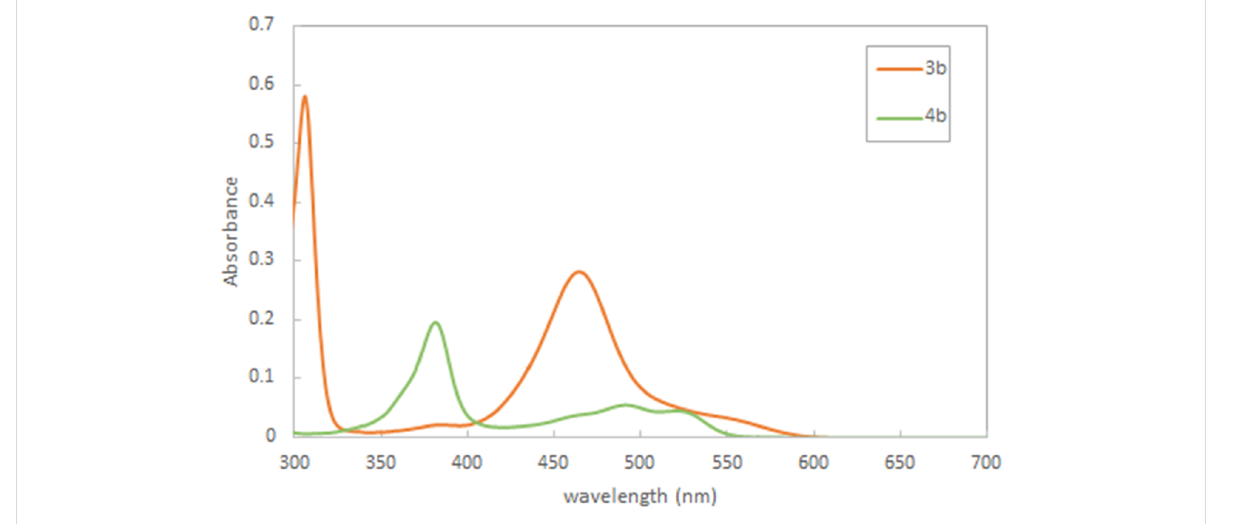
Figure 4: UV–vis spectra of thioxanthylium salts 3b and 4b (0.1 mM) in CH 3 CN.